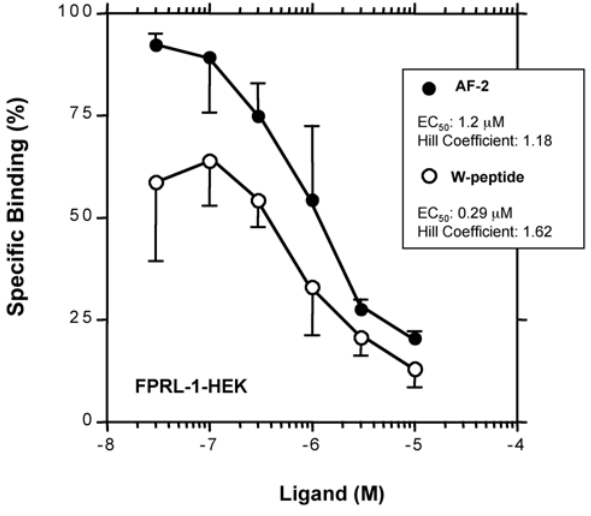
FIGURE 1. Competition binding with AF-2 and W-peptide ligands on FPRL-1 HEK cells . Competition binding curves for AF-2 ( ● ) and W- peptide ( ○ ) in FPRL-1 HEK cells. Both peptides displaced [ 125 I-Tyr]- Ac2-26 tracer from binding to FPRL-1 HEK cells and approximate EC 50 and Hill constant are reported. Data presented as mean ± SEM of three independent